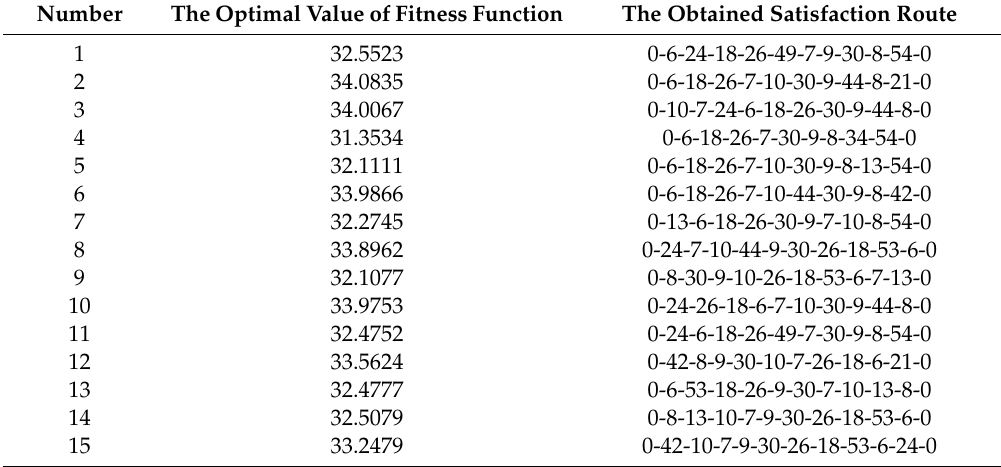
Table 10. The results of 15 tests using the PGA (60